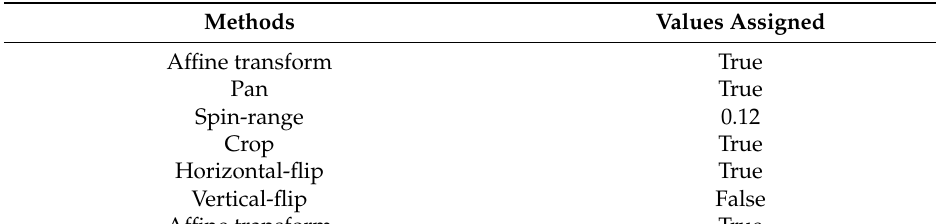
Figure 2. A visual example of the proposed preprocessing step to enhance the contrast of MRI images, where figure ( a , c ) are the original and ( b , d ) are with noise removed and enhanced.